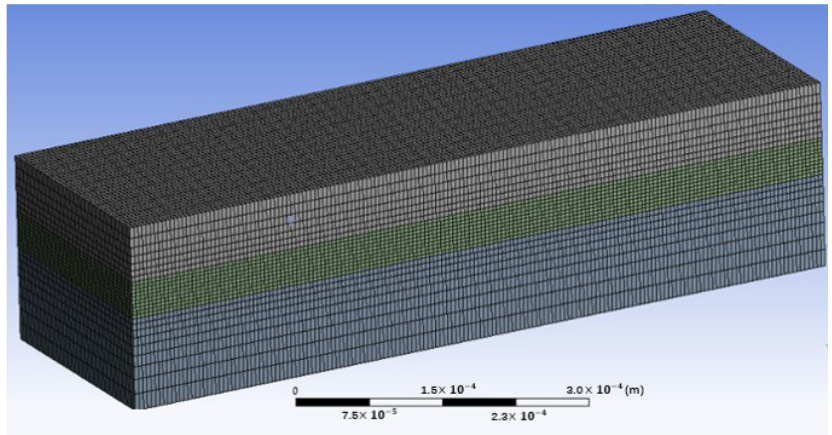
Figure 3. Meshing generation for simulation in laser – powder interaction.